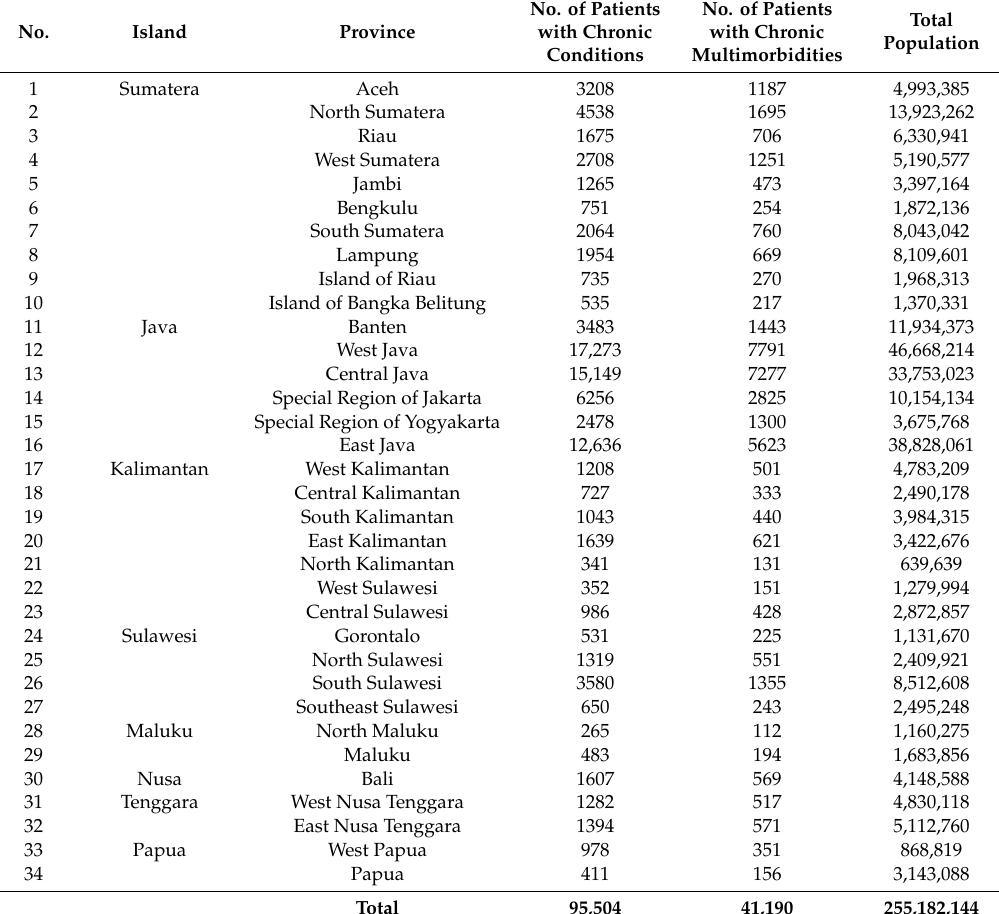
Figure 4. Patterns of healthcare utilization in chronic disease patients. Table 1. Distributions of the numbers of patients with chronic conditions and multimorbidities.